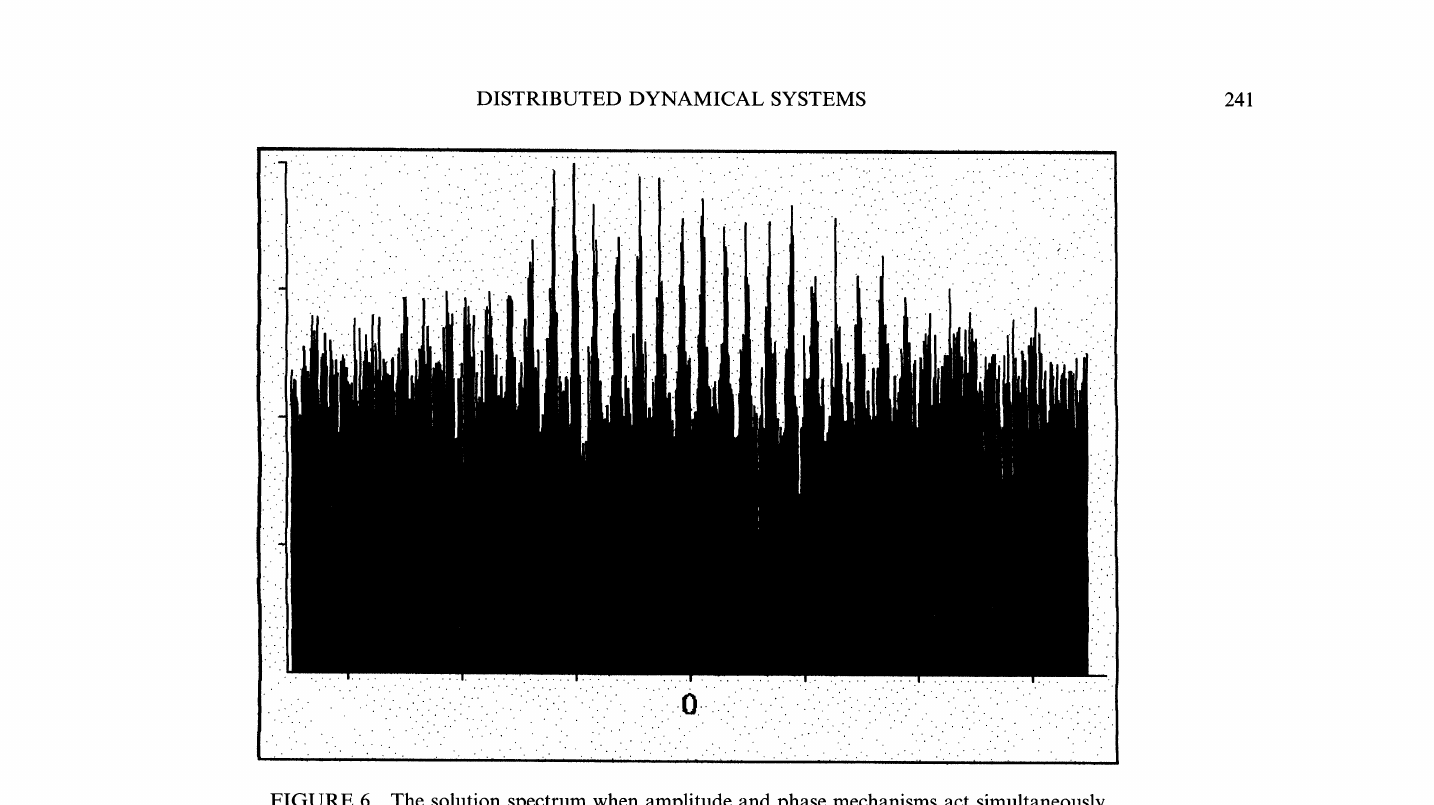
FIGURE 6 The solution spectrum when amplitude and phase mechanisms act